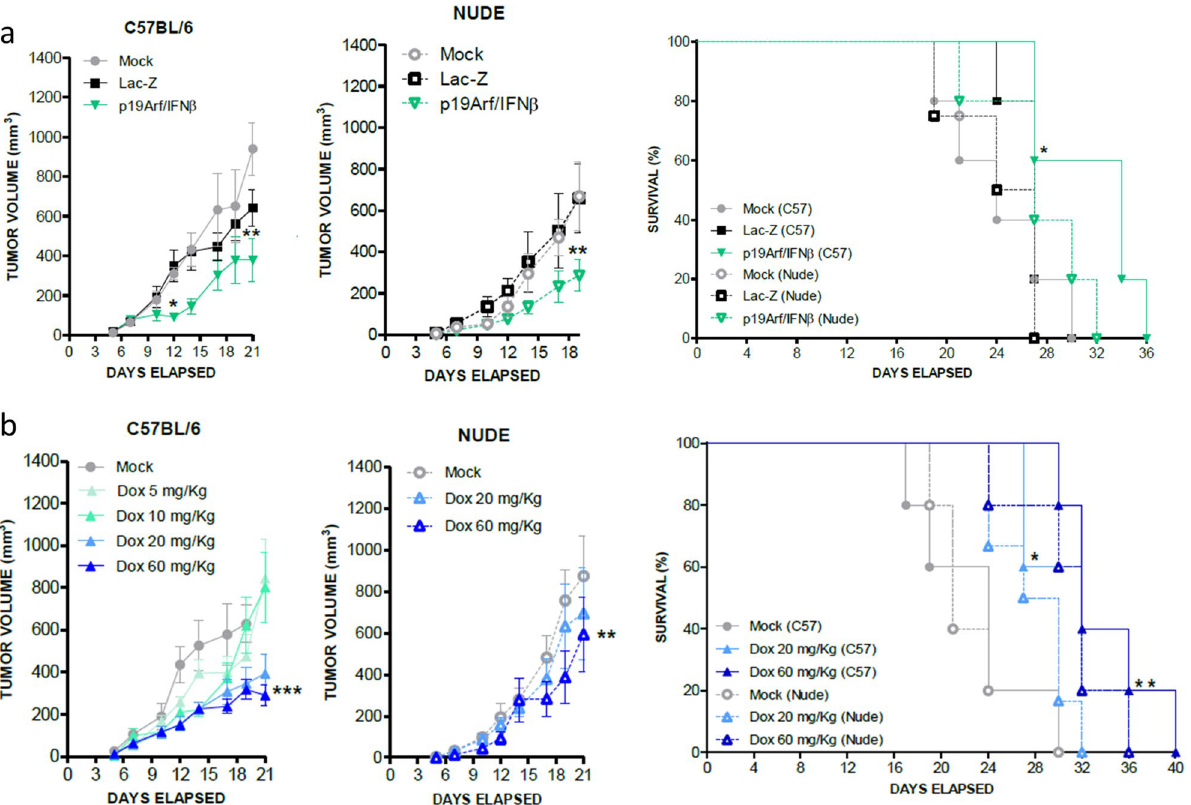
Figure 1. Use of p19Arf/IFNβ and doxorubicin as monotherapies inhibits progression of established MCA tumors in immune competent hosts. ( a ) Progression of MCA tumors in C57BL/6 and Nude mice upon in situ PBS (Mock), Lac-Z or p19Arf/IFNβ gene therapy. [Two-way Anova and Bonferroni post-test]. Survival analysis comparing immune competent C57BL/6 mice and immune deficient Nude mice [Log Rank Mantel- cox test, followed by Wilcoxon post-Test]. n = 5 for the p19Arf/IFNβ (C57), Lac-Z (C57), Mock (C57, p19Arf/ IFNβ (Nude), n = 4 for Mock (Nude) and Lac-Z (Nude) groups. ( b ) Progression of MCA tumors treated intratumorally with PBS (Mock) or doxorubicin (Dox) and performed in C57BL/6 and Nude mice. [Two-way Anova and Bonferroni post-test]. Survival analysis comparing immune competent C57BL/6 and immune deficient Nude mice. [Log Rank Mantel-cox test followed by Wilcoxon post-Test]. n = 6 for the Mock (C57), Mock (Nude), Dox 60 mg/kg (C57) groups; n = 4 for Dox 20 mg/kg (C57), Dox 20 mg/kg (Nude) and n = 3 Dox 60